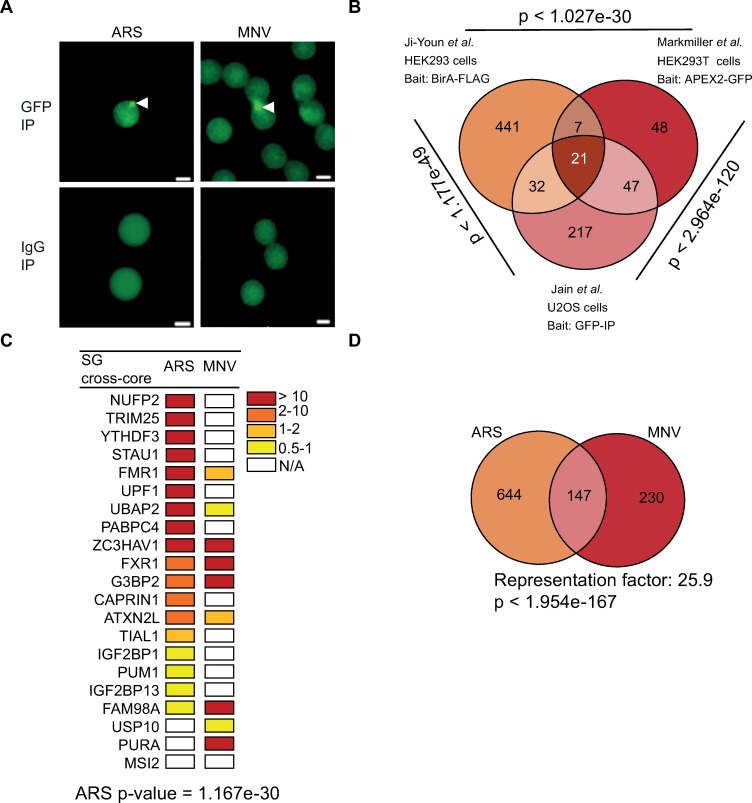
MNV-induced G3BP1 granules are distinct from arsenite-induced stress granules.(A) Dynabeads bound to GFP and to IgG analysed by epifluoresence microscopy in arsenite-stressed and in MNV-infected cells; bead-bound G3BP1 granules are indicated by white arrows (B) Venn diagram of the SGs interactome showing the common elements between three different stress granules (SG) interactome identified in human cells. The hypergeometric p-value is displayed by the side of each group. (C) Heat map representing the 21 proteins identified as “SG cross-core” in arsenite-treated and MNV-infected G3BP1 interactome ranked by the Log2 fold changes. Fold changes are indicated with from red to yellow colour bar and white for N/A. (D) Venn diagram between 795 proteins identified in ARS and 379 in MNV infected cells. The representation factor showed the enrichment over the expected and p-value is based on the cumulative distribution function (CDF) of the hypergeometric distribution of the data set over the mouse proteome.